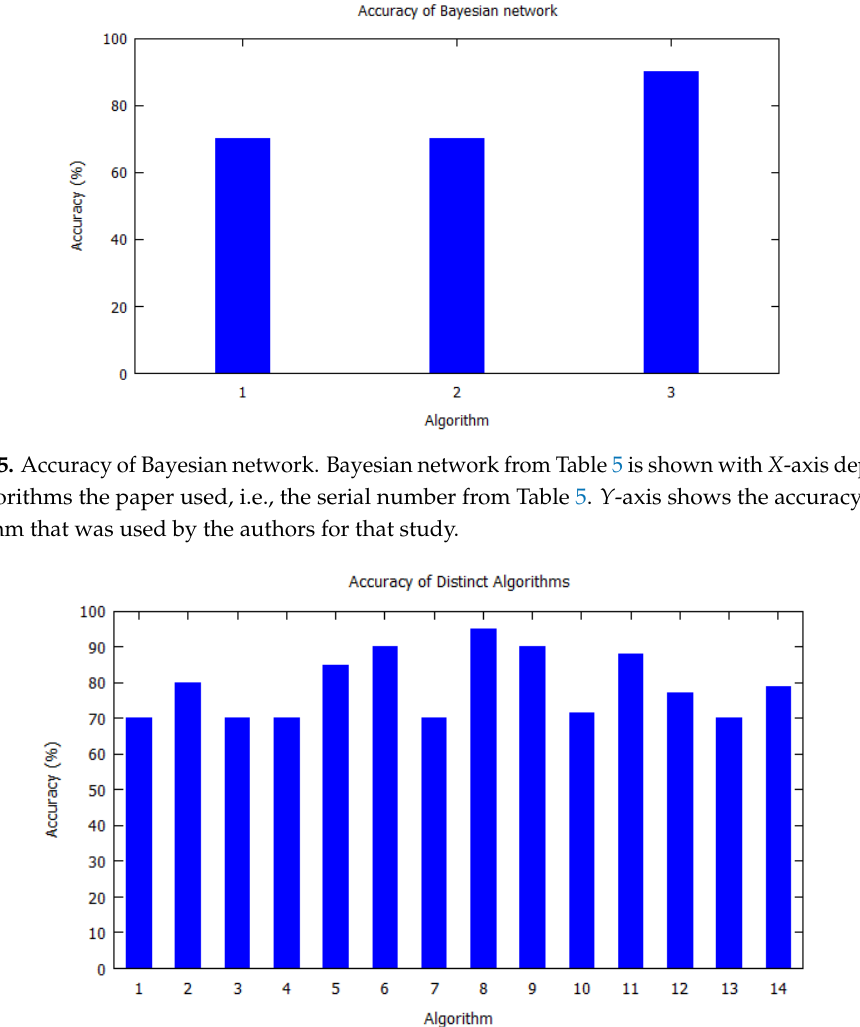
Figure 6. Accuracy of Distinct Algorithms. Distinct Algorithms from Table 6 is shown with X -axis depicting the algorithms the paper used, i.e., the serial number from Table 6. Y -axis shows the accuracy of the algorithm that was used by the authors for that